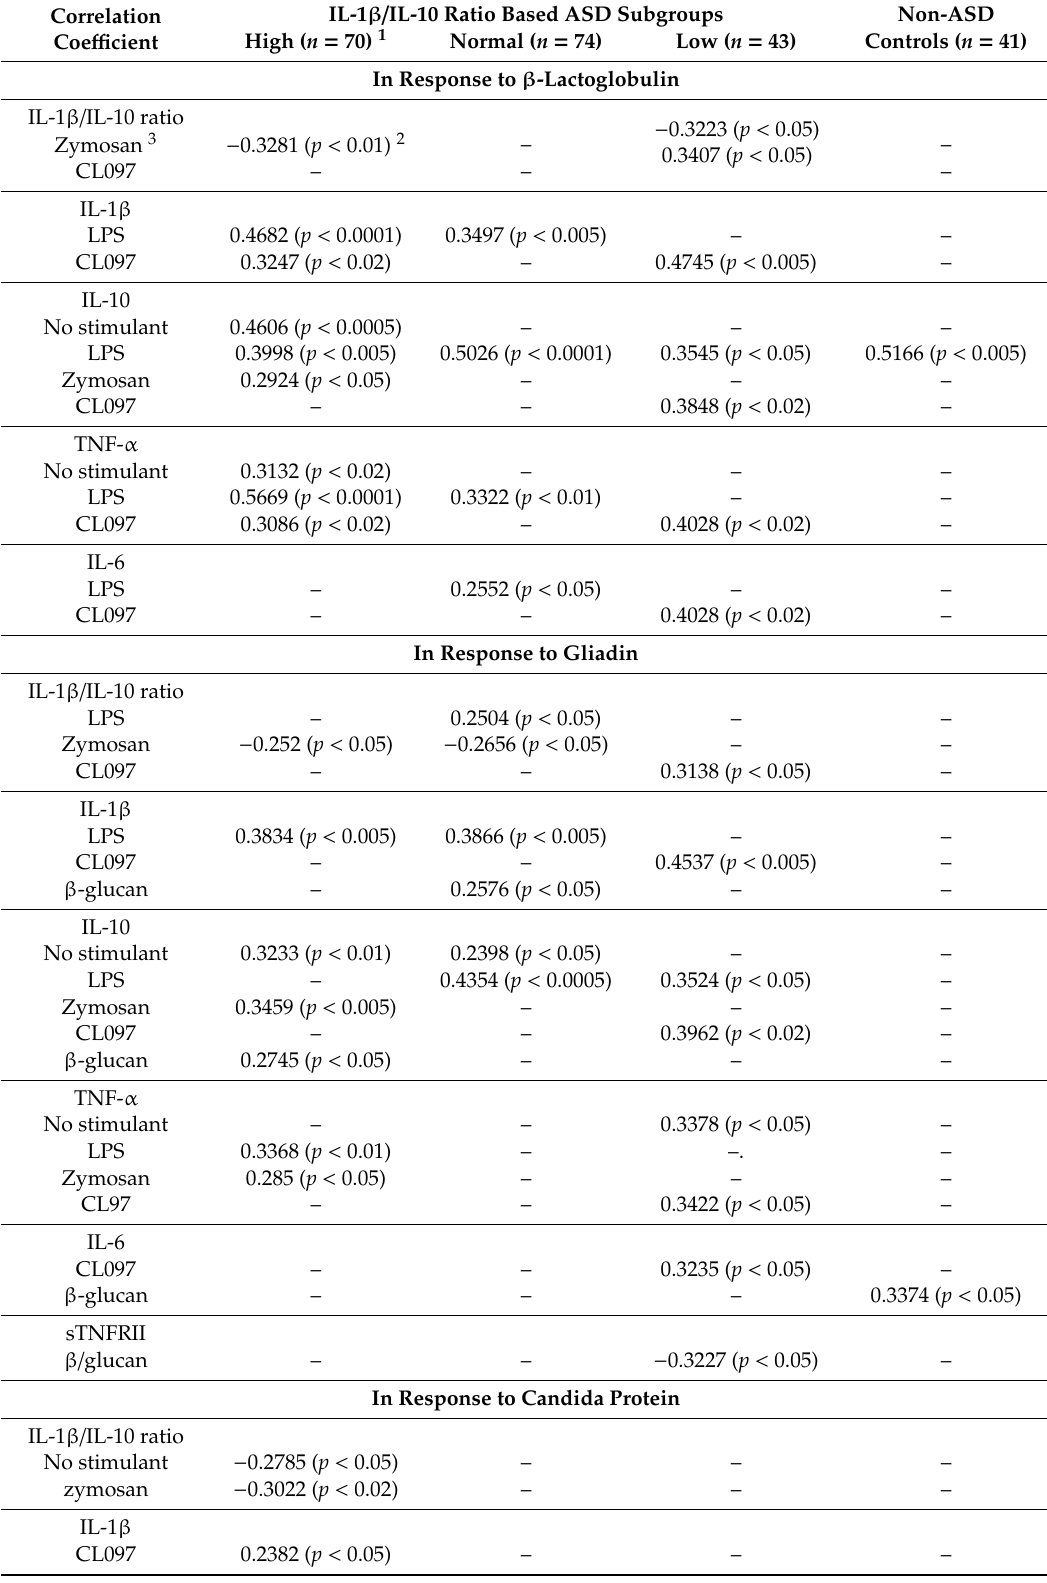
Table 7. Correlation between IL-10 production by PBMCs and monocyte cytokine